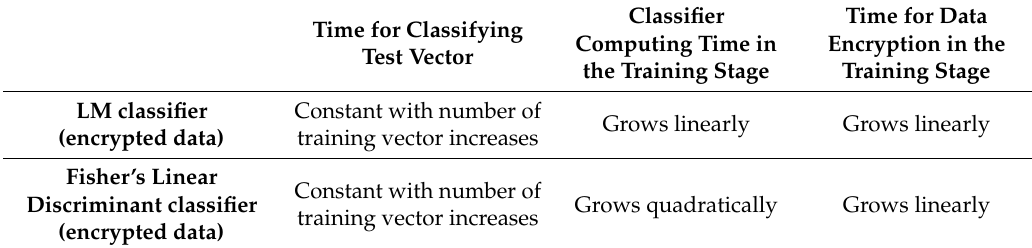
Table 6. Performance comparison of the classifiers